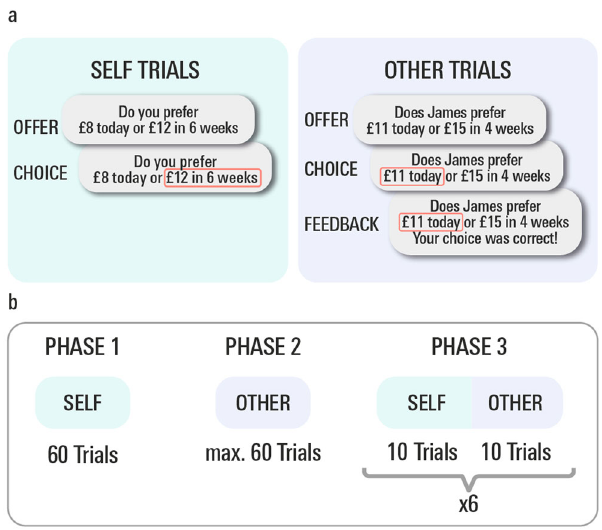
Fig. 1 Social delay discounting task. a Example trial for ‘ self ’ and ‘ other ’ trial types. In self trials, participants see an offer of a smaller amount of money they can receive on the same day or a larger amount of money they can receive after a variable delay period. Subjects were instructed to indicate their preference according to their true personal preference and, to enforce expression of true preferences, they were told that one trial would be chosen at random to determine their pay out. In ‘ other ’ trials, subjects chose between the smaller, immediate and the larger, delayed option on behalf of another person, and received feedback on these choices thereby enabling them to learn the others ’ delay discounting preferences. Individual scores of susceptibility to social in fl uence were de fi ned as the degree of change in one ’ s own discount rate towards the preference of a social partner (i.e., log k self_phase3 – log k self_phase1 ). b Experimental Design. In phase 1, participants completed 60 ‘ self ’ trials, in phase 2, participants engaged in ‘ other ’ trials for a minimum of 20 trials, until either the participant got eight correct answers out of the most recent 10 trials, or until 60 learning trials were